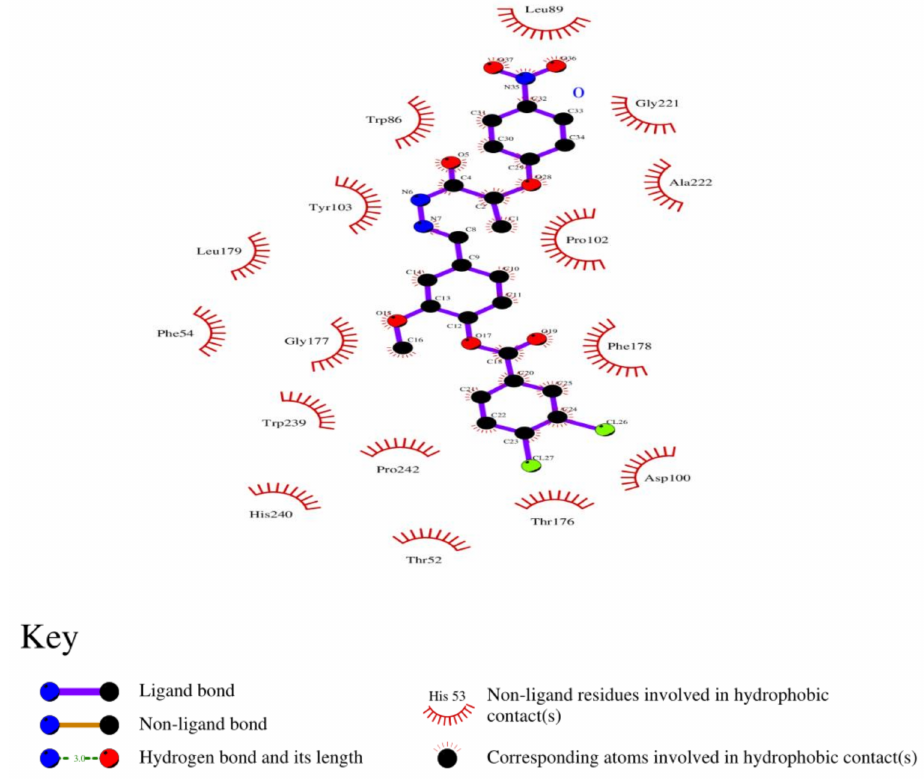
Figure 6. 2D interaction of 2-[[5-[(4-ethylphenoxy)methyl]-4-prop-2-enyl-1,2,4-triazol-3-yl]sulfanyl]- N-[3-(trifluoromethyl)phenyl]acetamide and HCV E2